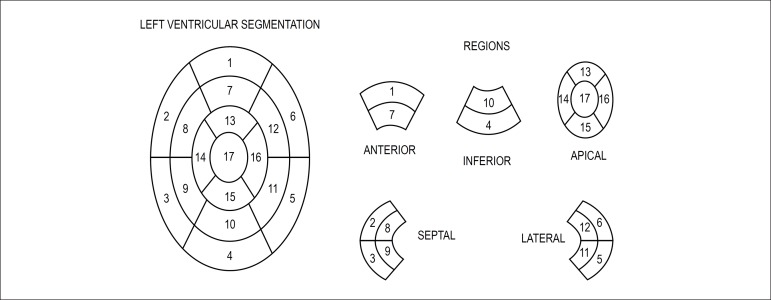
Left ventricular segmentation proposed by the American Heart
Association.